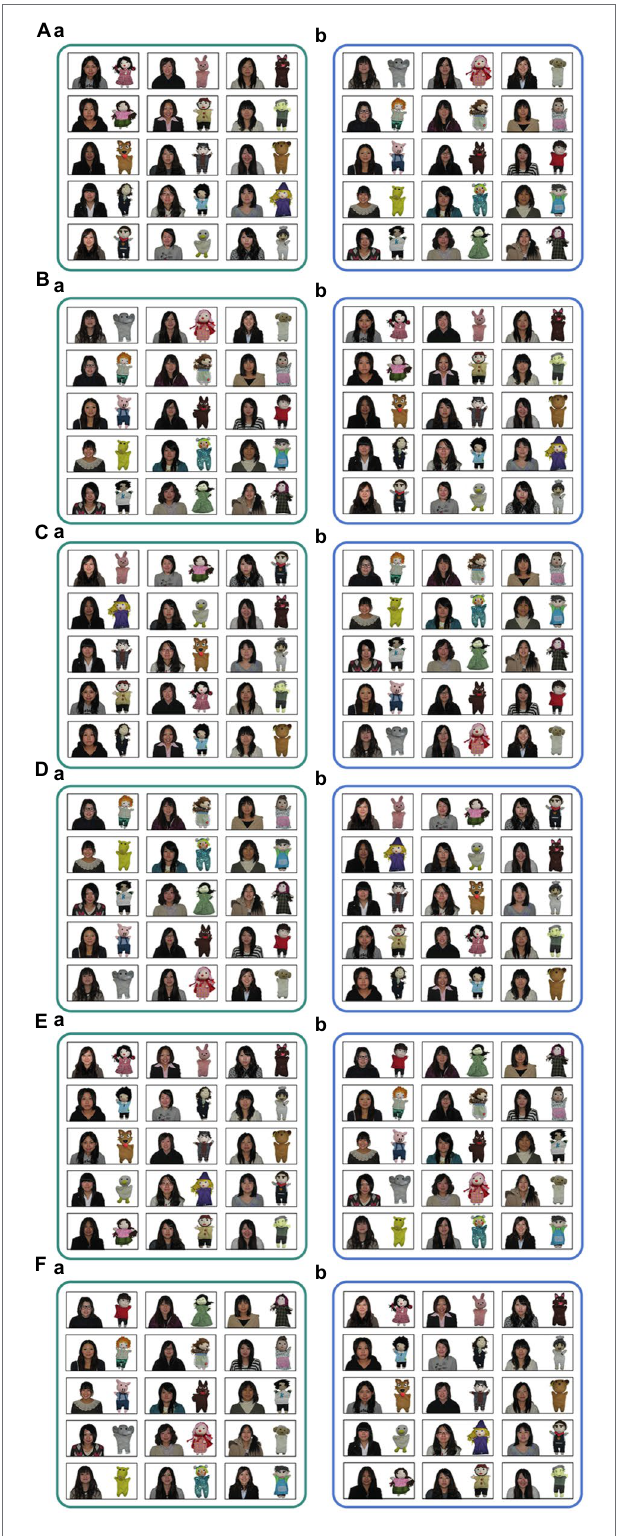
FIGURE 2 | Examples of stimuli on the questionnaires. (A) A stimulus sample of 16 versions of questionnaires. Thirty doll-maker pairs